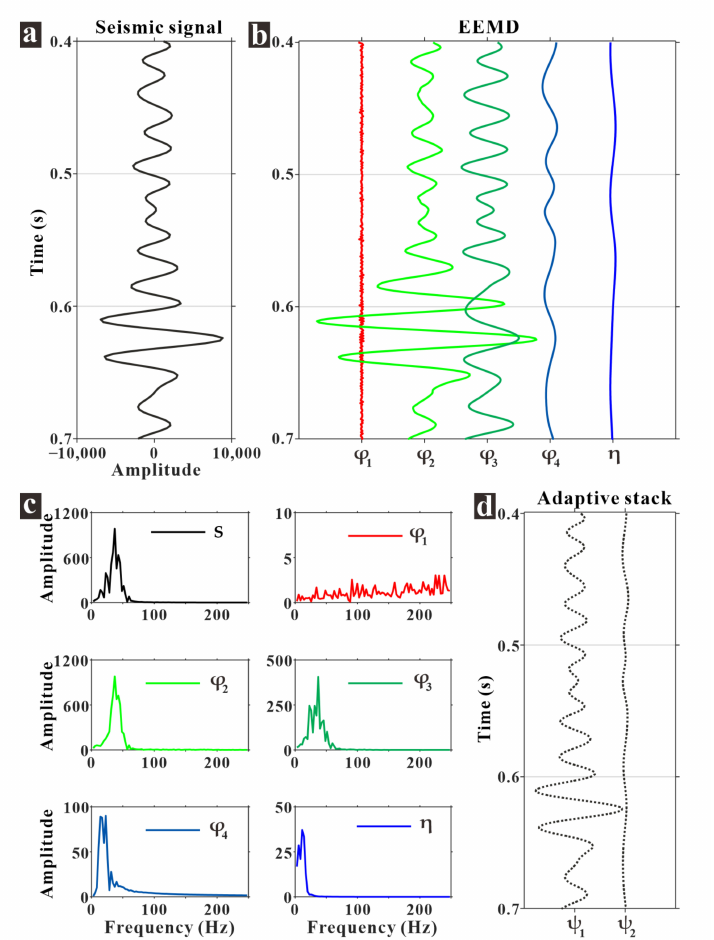
Figure 4. Real seismic signal ( a ), five components decomposed by EEMD ( b ), frequency spectra of the real seismic signal s and the five components ( c ), and the sub-signals obtained by adaptive stacking ( d ).